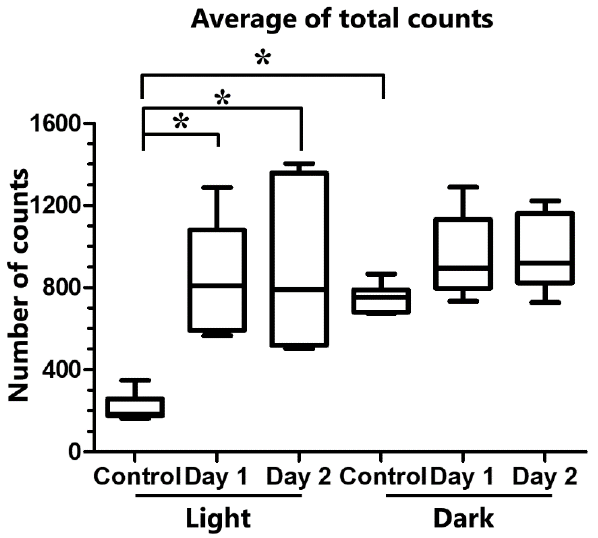
Figure 2. The 2-h total count average. Under the control condition, total count average was higher in the dark cycle compared with such in the light. In the light, the count average was significantly higher for day 1 and day 2 under sleep deviation compared with control conditions (* p < 0.05). In the dark, the count average was slightly higher under sleep deviation, which was not significant compared with control. Data are shown as mean ± standard error of